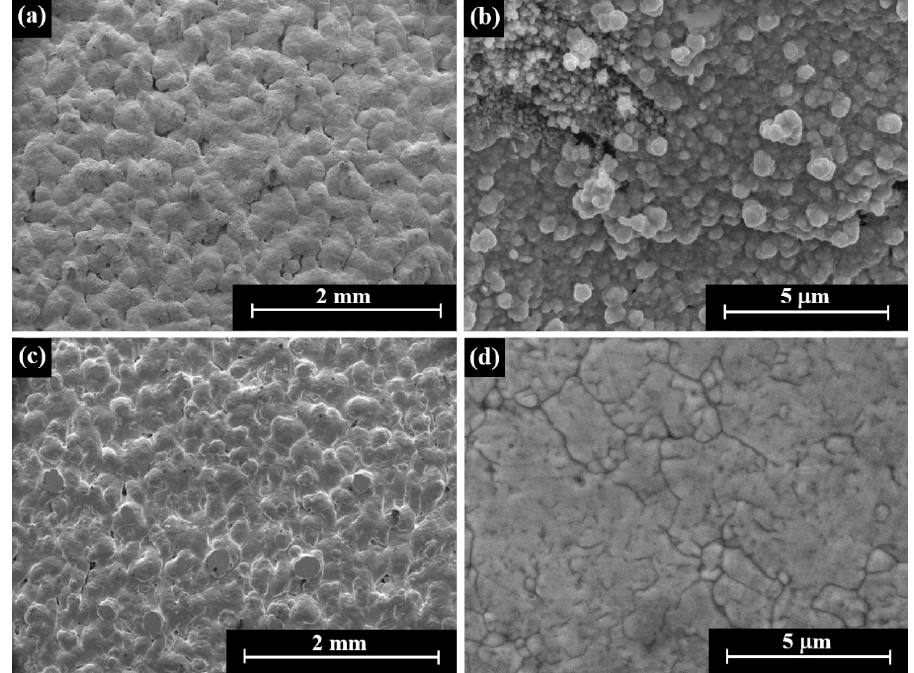
Figure 6. The laboratory-developed silver coating on top of AM-LPBF AlSi10Mg substrate: ( a ) film thickness as a function of deposition time with and without silanization; and ( b ) RMS and Ra surface roughness without silanization (measured by profilometer).